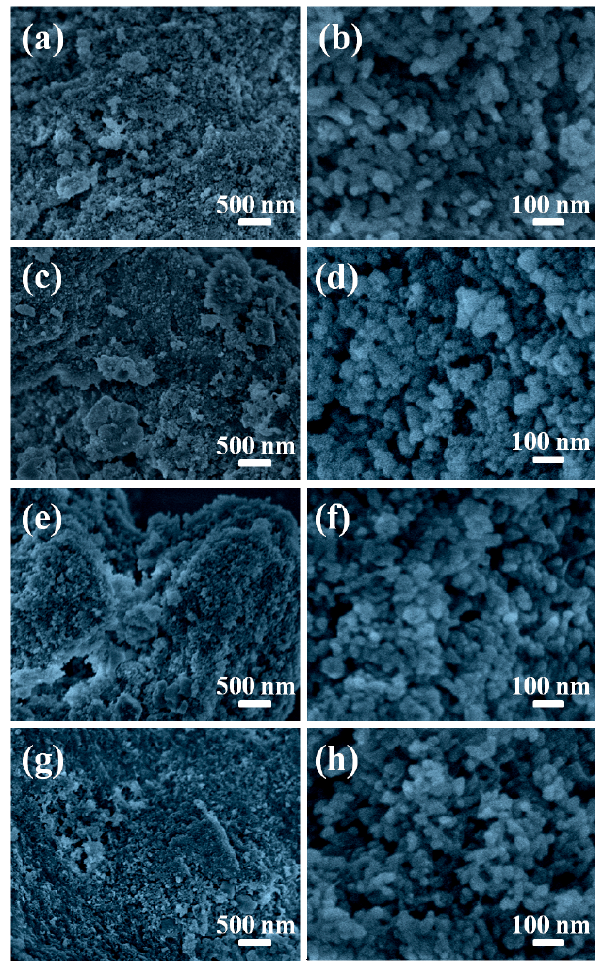
Figure 8. FE-SEM images of the cellulose/HA nanocomposites prepared by microwave-assisted hydrothermal method at 180 °C for 10 min using different phosphorus sources: ( a , b ) NaH 2 PO 4 ·2H 2 O; ( c , d ) ATP; ( e , f ) CP; ( g , h ) FBP. The magnifications for the low-magnification